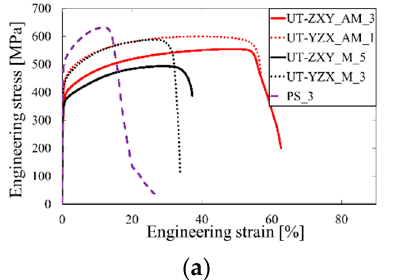
( b ) force-displacement curve of the biaxial test, ( c ) force-displacement curve of the compression test.